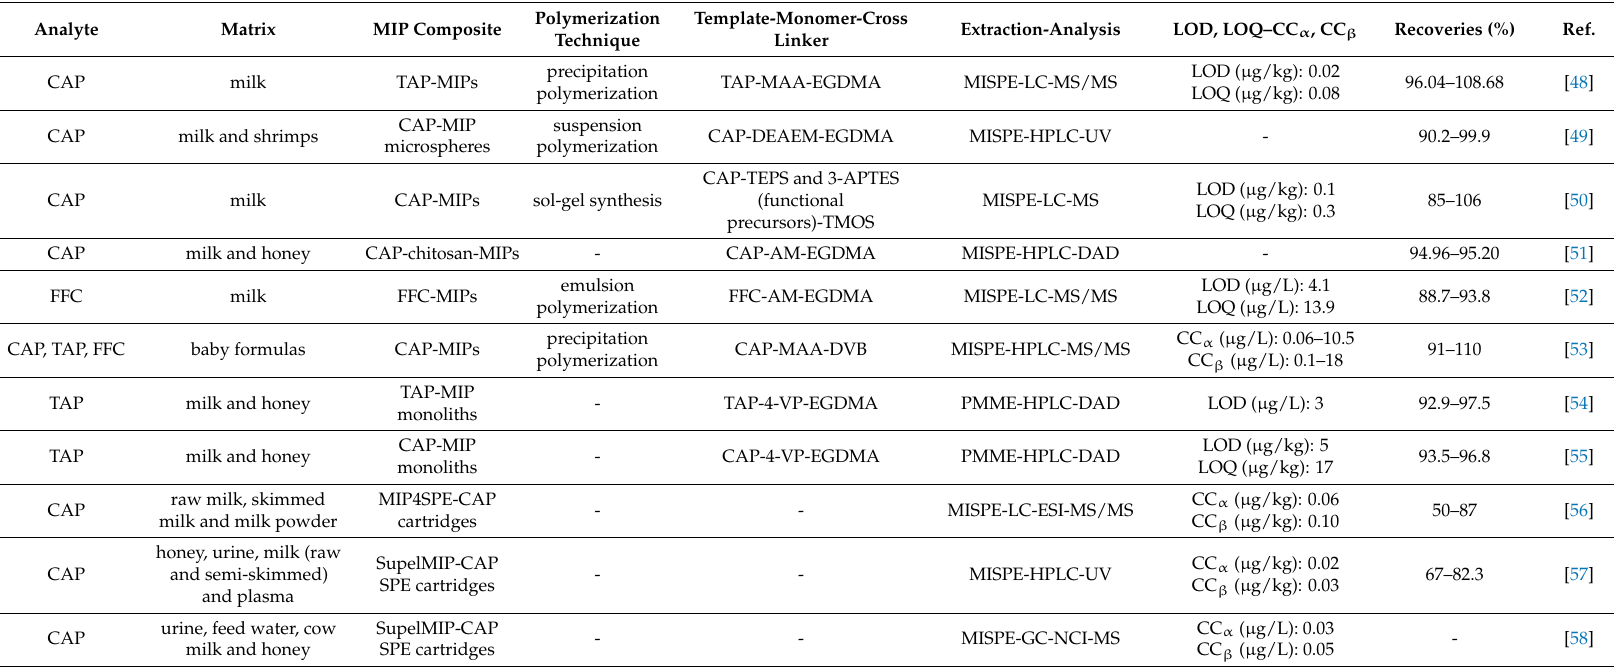
Table 1. MIPs applications for the determination of amphenicols in milk